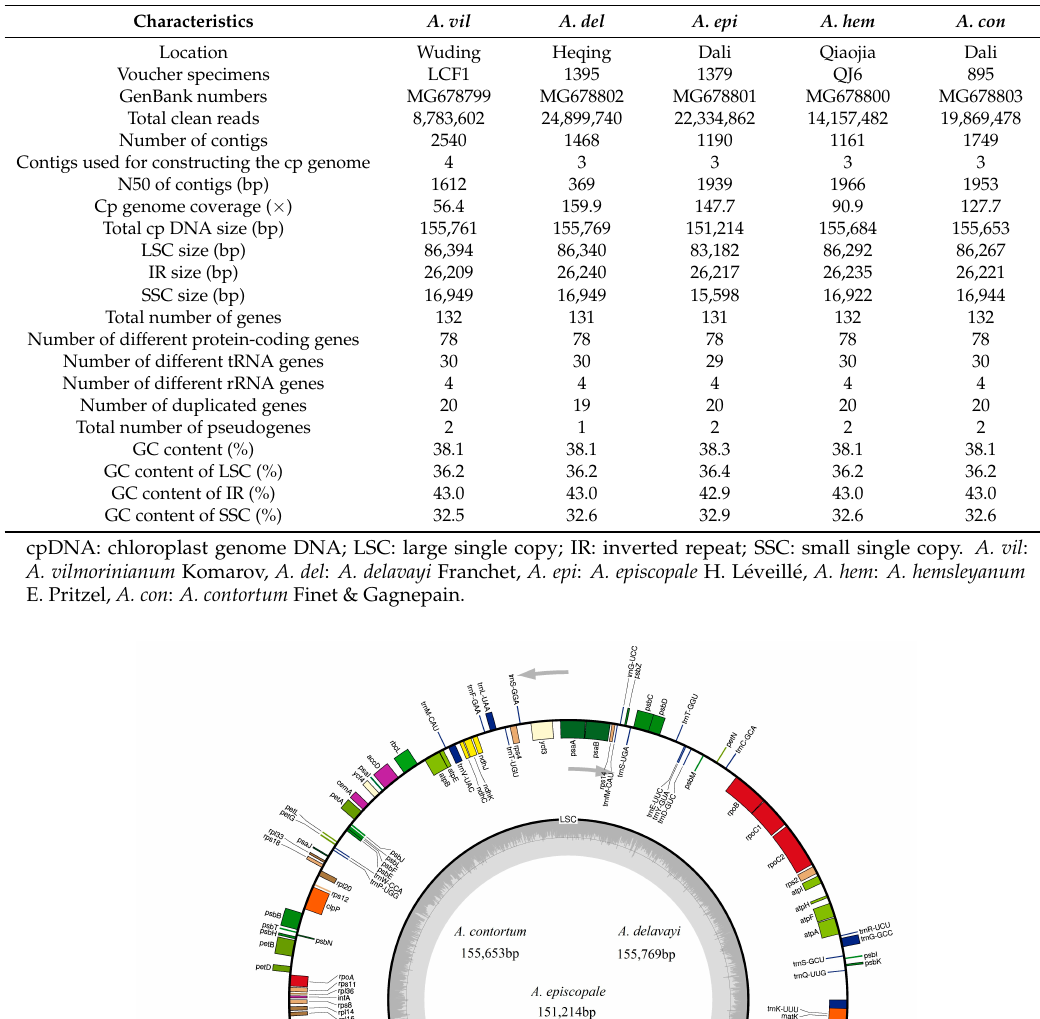
Table 1. The basic characteristics of chloroplast genomes of five Aconitum species.